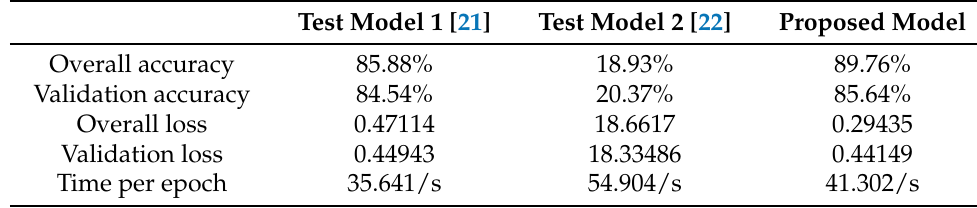
Table 17. First observation after 10 epochs of training of experiment 2.